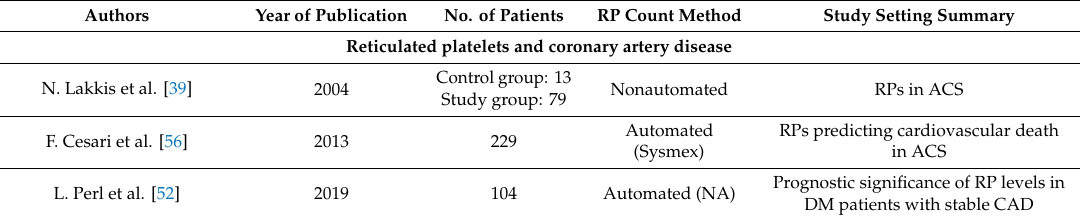
Table 2. Overview of the di ff erent studies of importance in the cardiovascular